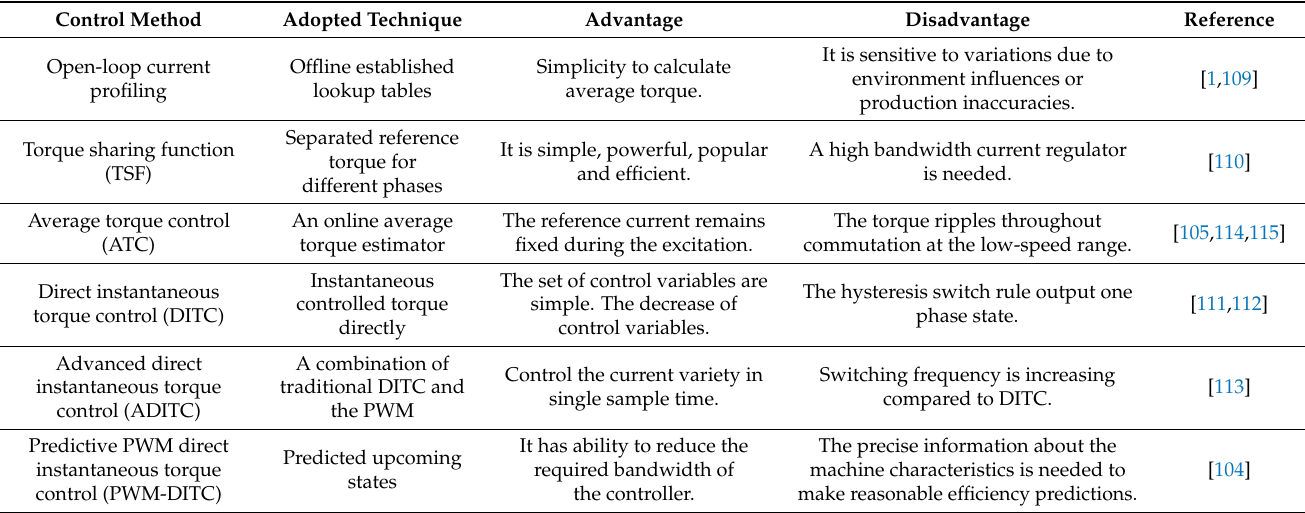
Table 4. Summary and comparison of SRM control